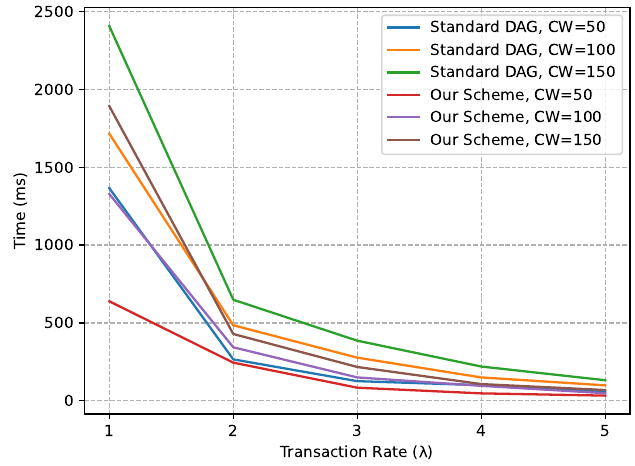
Figure 4. Confirmation Delay of Sites.